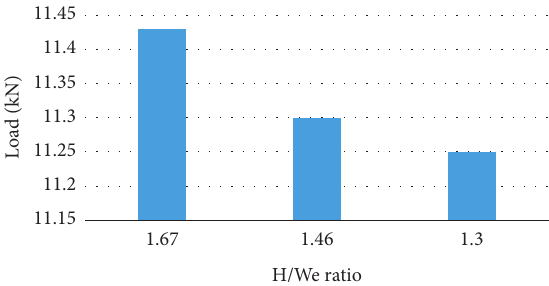
Figure 13: Effect of concrete strength on the ultimate load capacity e ) on the ultimate load with U-type